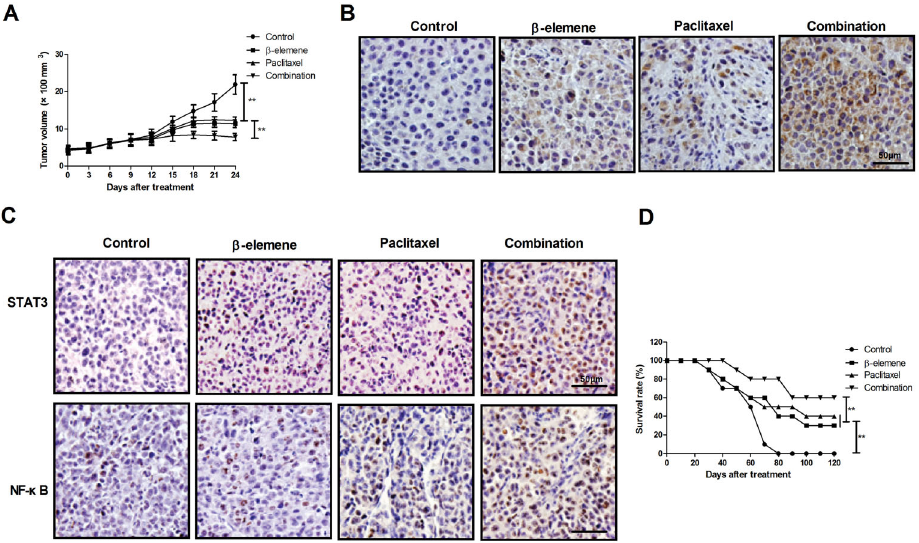
Figure 8. Anti-cancer effect of b -elemene + paclitaxel in SKOV3-bearing mice. A , Tumor growth in SKOV3-bearing mice after receiving b -elemene and/or paclitaxel. B , Apoptotic tumor cells in tumor tissue after treatment with b -elemene and/or paclitaxel determined by TUNEL assay (magni fi cation bar: 50x). C , Protein expression of STAT3 and NF- k B in tumor tissue after treatment with b -elemene and/or paclitaxel (magni fi cation bar: 50x). D , Survival time of tumor-bearing mice after treatment with b -elemene and/or paclitaxel. Data